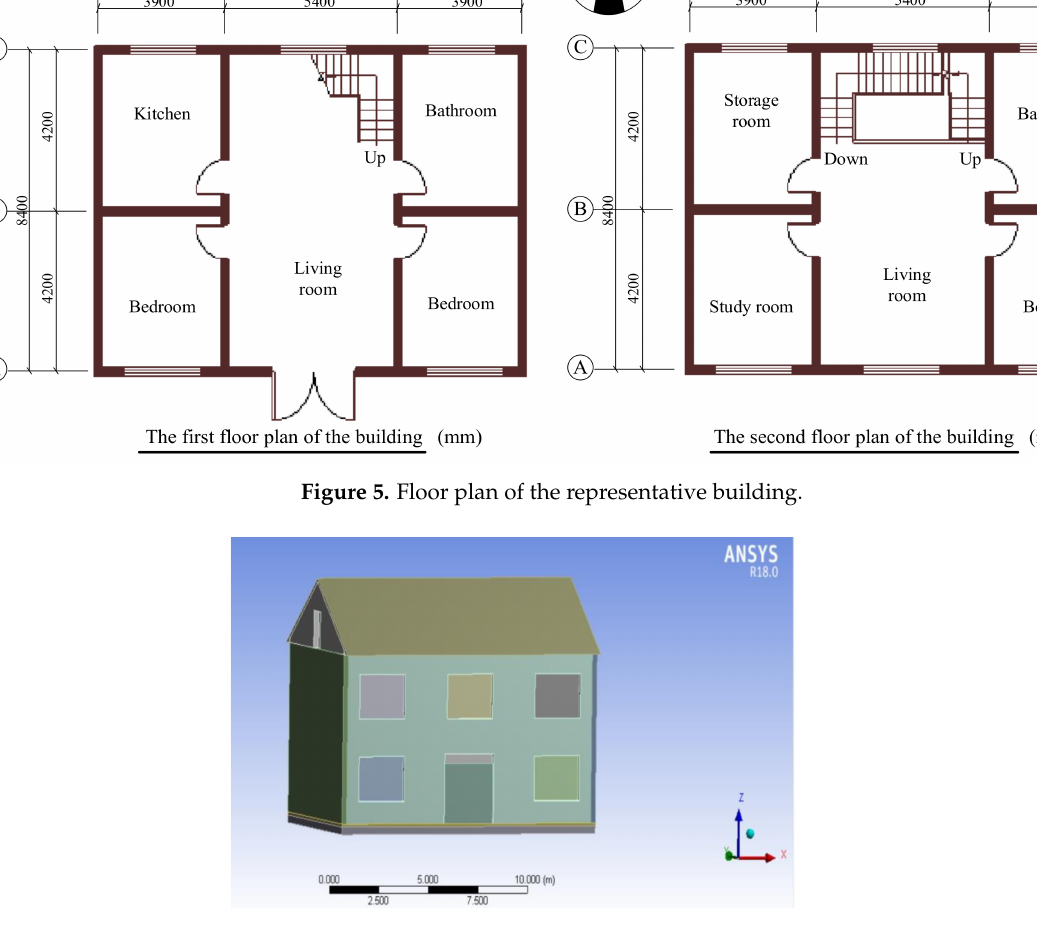
Figure 6. Geometric model of the representative building.